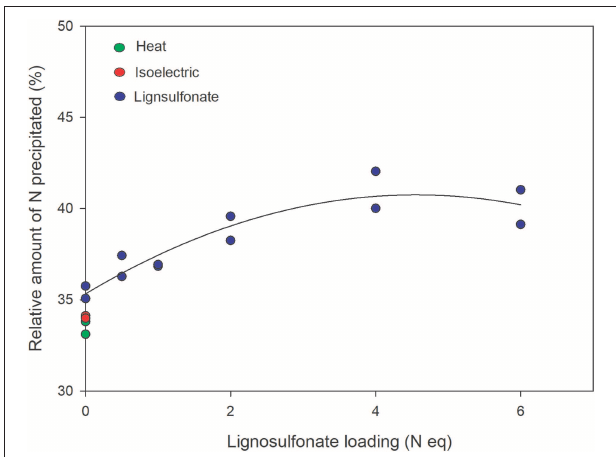
FIGURE 4 | Relative amount of N precipitated from grass-clover juice at different lignosulfonate loadings expressed as nitrogen equivalents (N eq), i.e., the mass of lignosulfonate relative to the amount of nitrogen. A loading of 6N eq corresponds to ∼ 1:1 ratio of lignosulfonate to crude protein. A quadratic regression line is included. Heat and isoelectric precipitation is included as reference method.